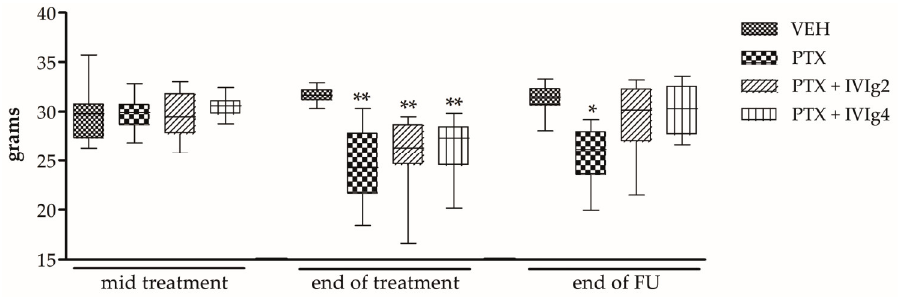
Figure 2. Effects of PTX and IVIg co-treatment on mechanical allodynia. IVIg alleviates mechanical allodynia in a rat model of PIPN at the end of FU. * p < 0.01, ** p < 0.001 vs. VEH ( n = 12 rats/group). The statistical analysis was performed using the Kruskal-Wallis test.